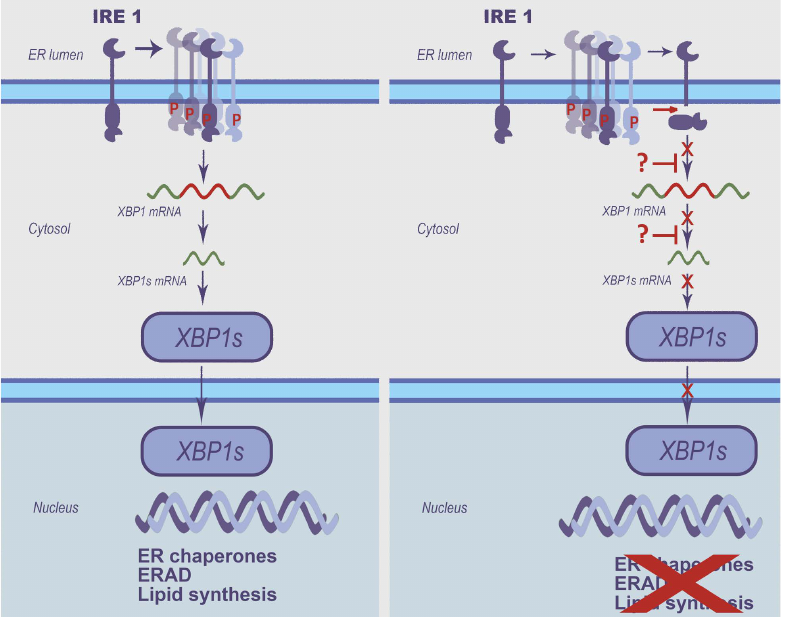
Figure 6. A model explaining the modulation of the Ire1-Xbp1 pathway in enterovirus-infected cells by the induction of Ire1 phosphorylation and inactivation through multiple mechanisms, including proteolytic cleavage. The activated Ire1-Xbp1 pathway in uninfected ( left ) or enterovirus-infected ( right ) cells is